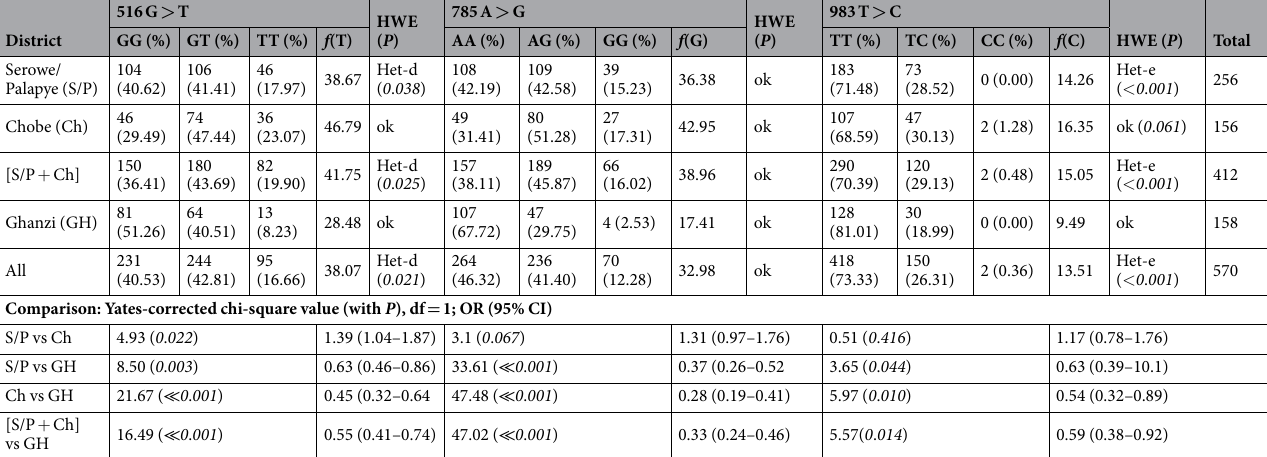
Table 1. Genotype and allele frequencies for CYP2B6 516-785-983 SNPs and comparisons among the groups. HWE: Hardy-Weinberg equilibrium test (with P , when significant). Het-d: significant heterozygous defect; Het-e: significant heterozygous eccess. Comparisons were made among districts of different ethnic composition (pairwise or combined) for each SNP.